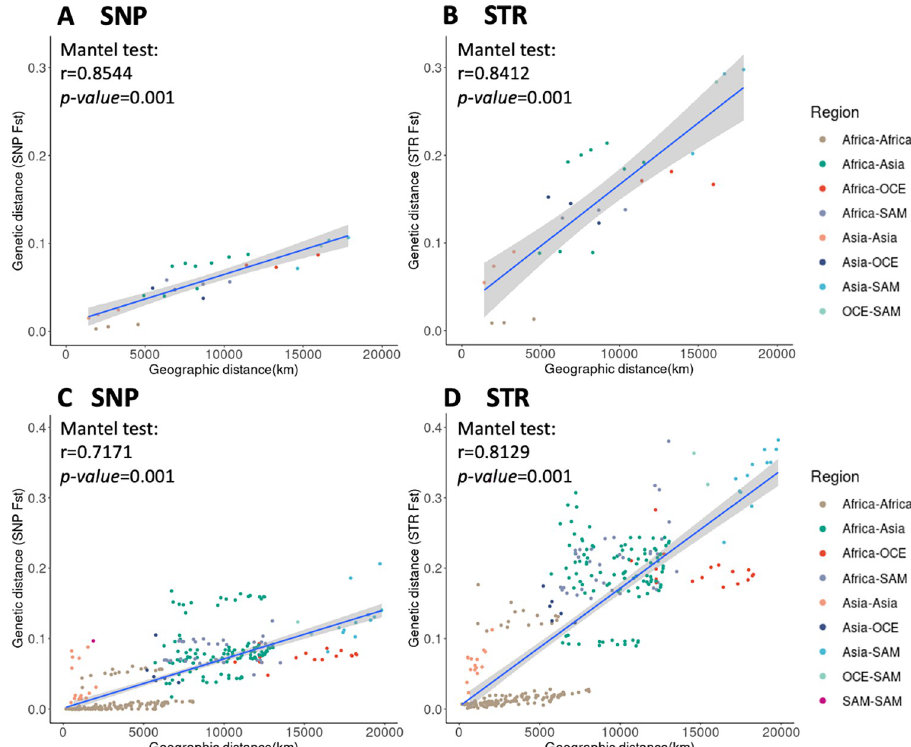
Fig 4. Pairwise genetic distance ( F ST ) and geographical distances (km) between populations and countries of P . falciparum . (A) SNP data of population pairs. (B) STR data of population pairs. (C) SNP data of country pairs. (D) STR data of country pairs. A Mantel test was used to measure the association.